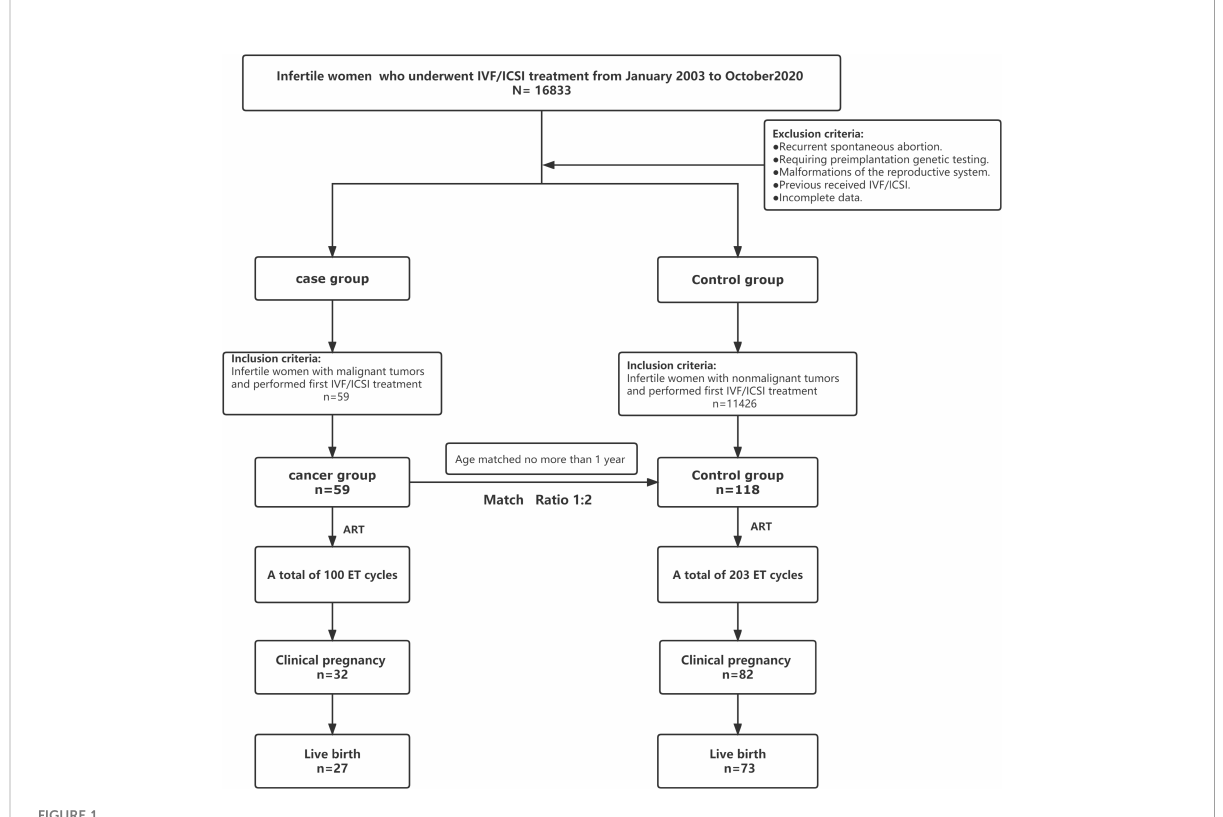
cycle outcomes were not signi fi cantly different between the